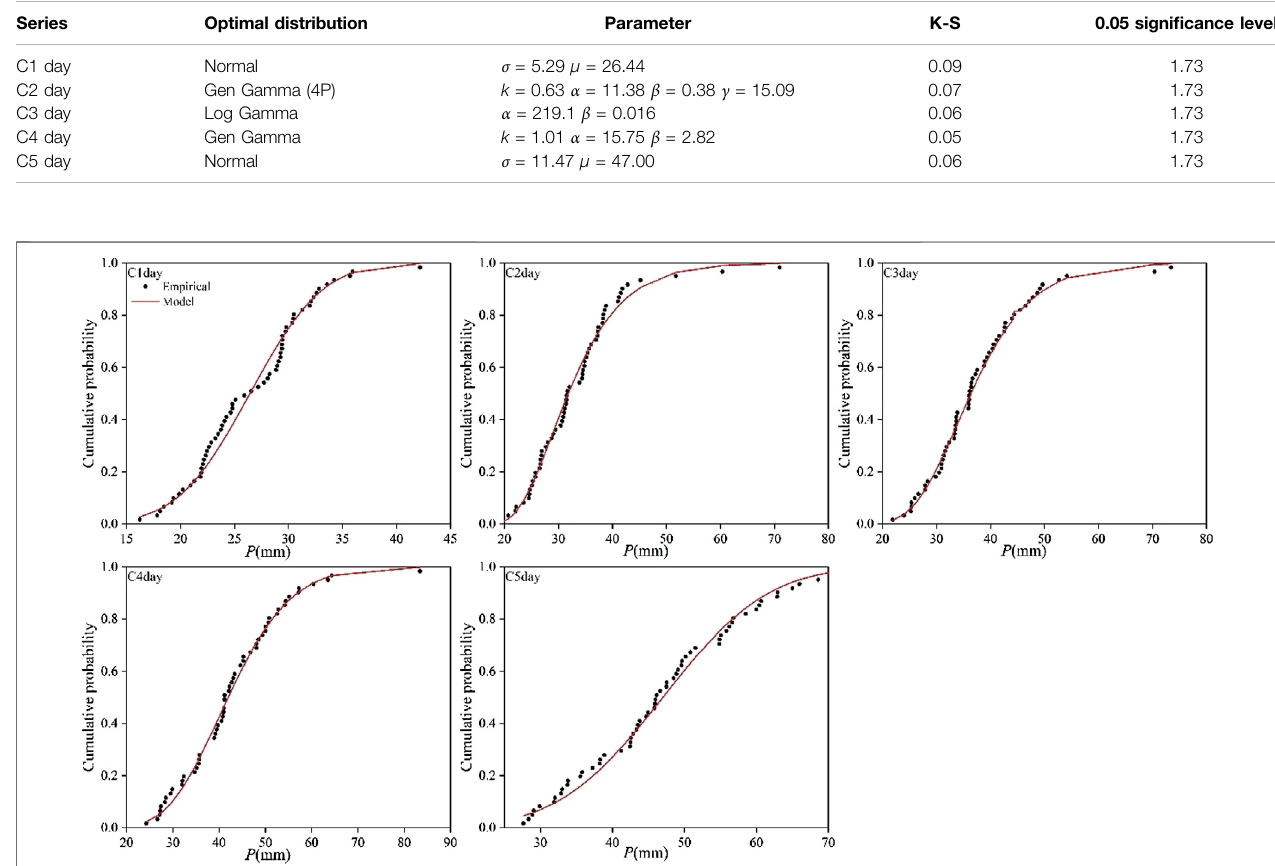
FIGURE 10 | Optimal distribution of C1 day, C2 day, C3 day, C4 day, and C5 day.